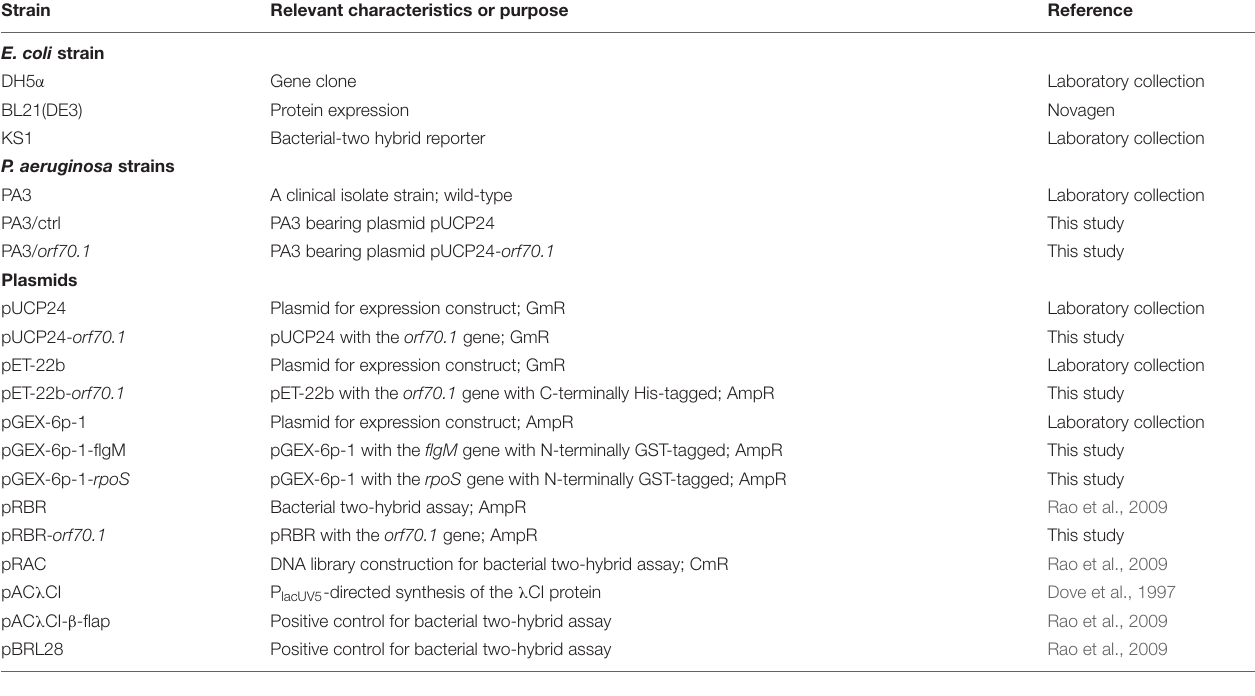
TABLE 1 | Plasmids and strains.